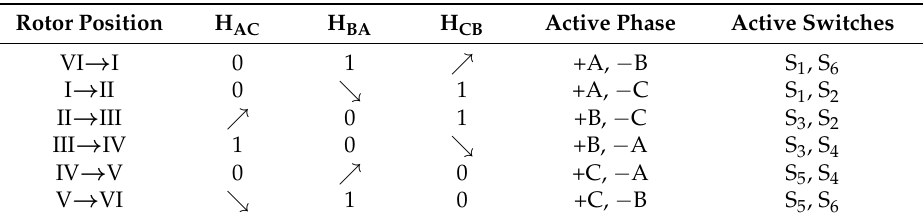
Figure 8. Digital position signals in the 120°- α mode. Table 3. Commutation control strategy in the 120°- α compensation mode.